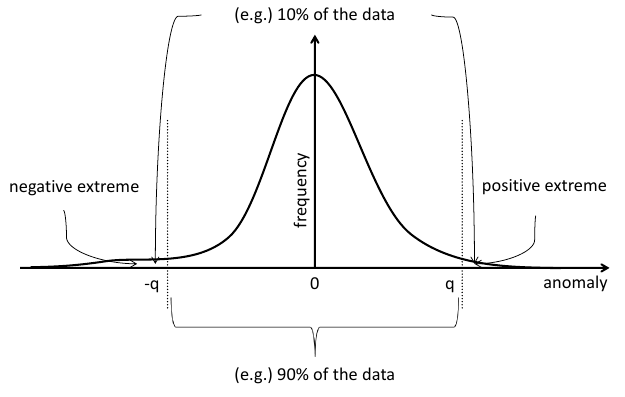
Figure 1. Sketch of how extremes are defined on GPP anomalies. A symmetric threshold q is set such that 90% (as an example) of the data anomalies fall in between − q and q . Those values which ex- ceed the threshold are defined to be extreme. In this example the ex- tremes are defined using the 10th-percentile definition (not to scale). Reprint of figure A2 in Zscheischler et al.